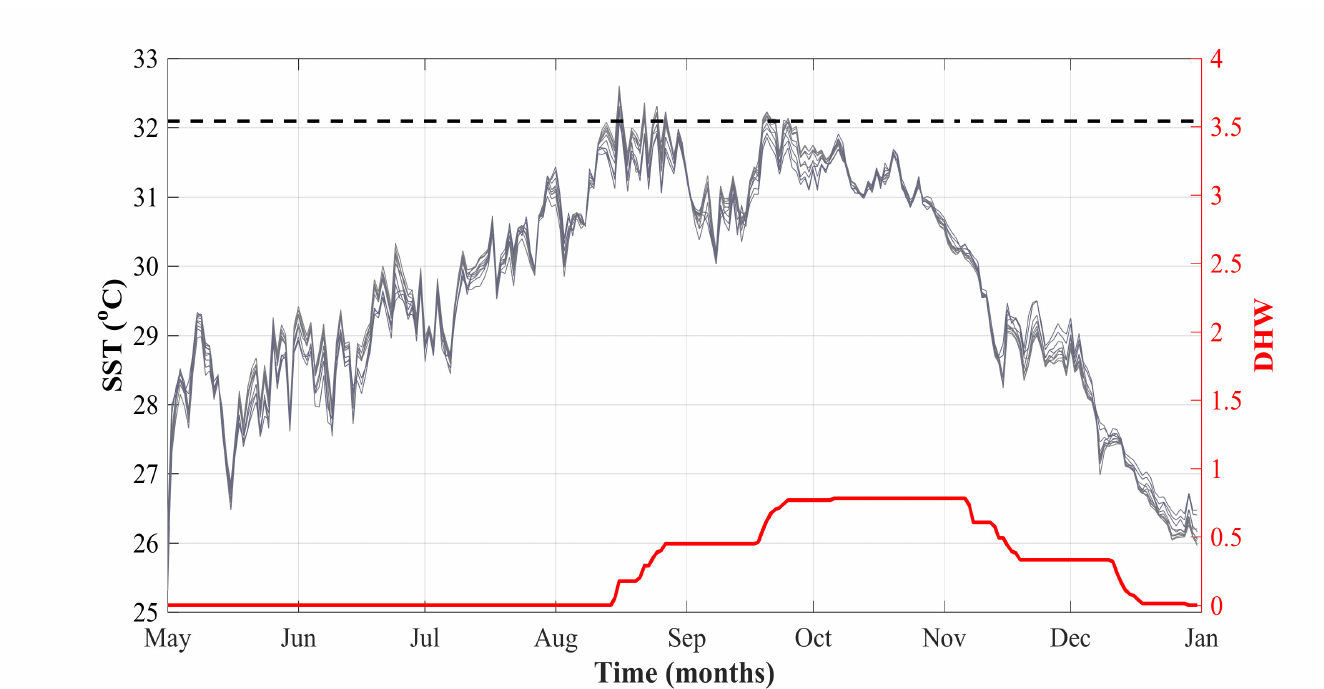
Fig 2. Sea surface temperature (SST), degree heating weeks (DHWs), and bleaching threshold at each reef location from May 1, 2015 to December 31, 2015. SST is represented by the gray shaded lines and the bleaching threshold temperature (averaged across all 11 reefs) is shown by the dashed black line. Both temperature values are shown in ˚C. The averaged DHWs across all 11 reefs are depicted by the solid red line. All data was downloaded from NOAA’s CRW 5km daily product [28].